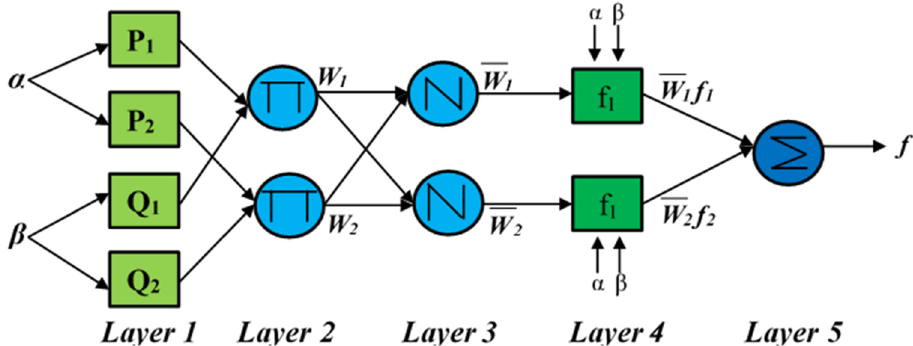
Figure 2. A schematic diagram of an ANFIS structure derived from a first-order Sugeno-type FIS. Reprinted with permission from Jang